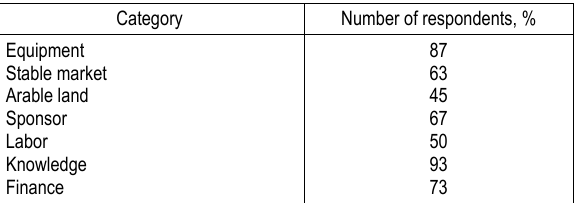
Table 5. Incentives needed by respondents Category Number of respondents,